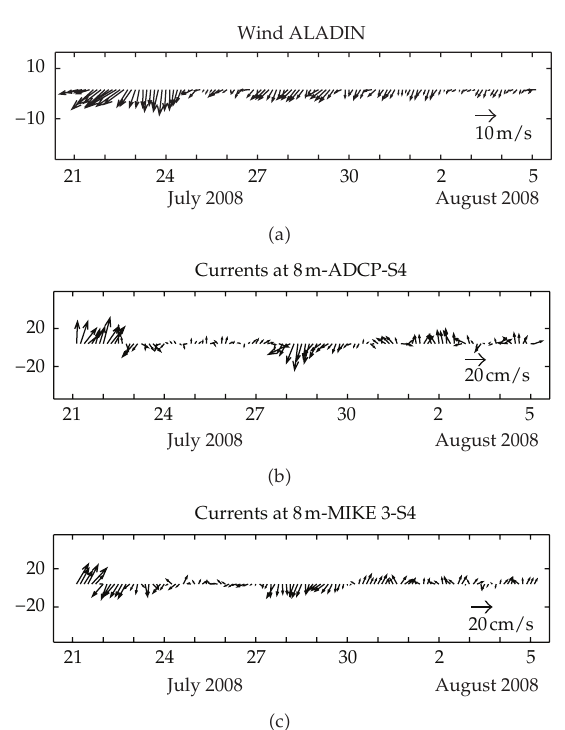
Figure 9: The same as on Figure 5 but for the ADCP station S4 during the summer period from 21st of July to 5th of August